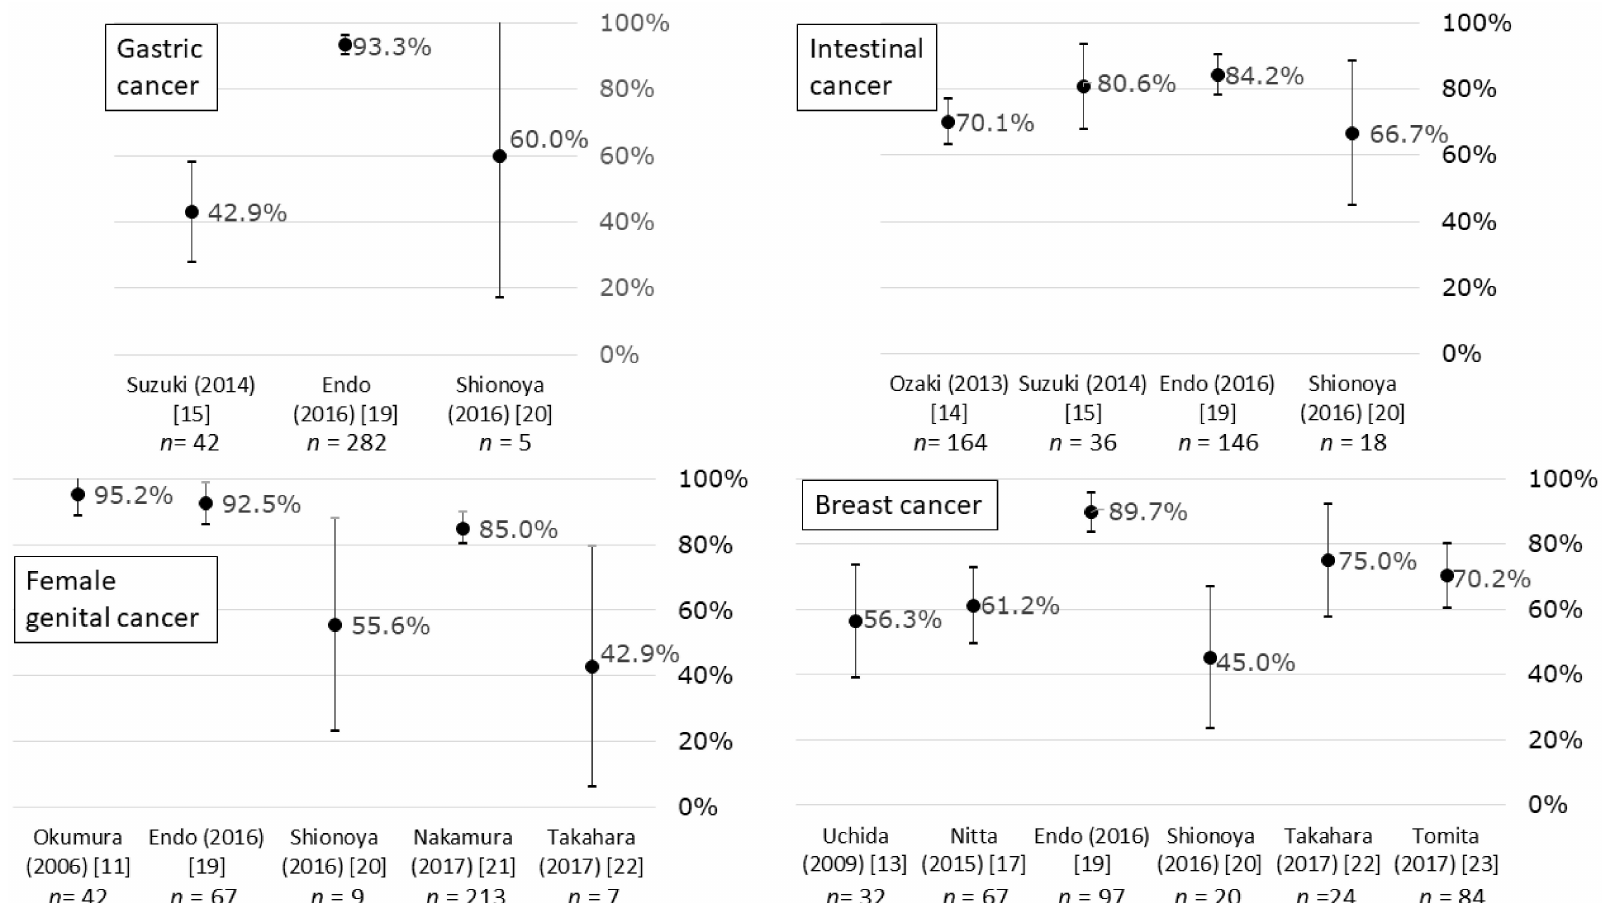
Figure 3. Return-to-work rates and 95% confidence intervals for (upper left) gastric, (upper right) intestinal (small intestine, colon, and rectum), (lower left) female genital (uterus and ovary), and (lower right) breast cancer patients in